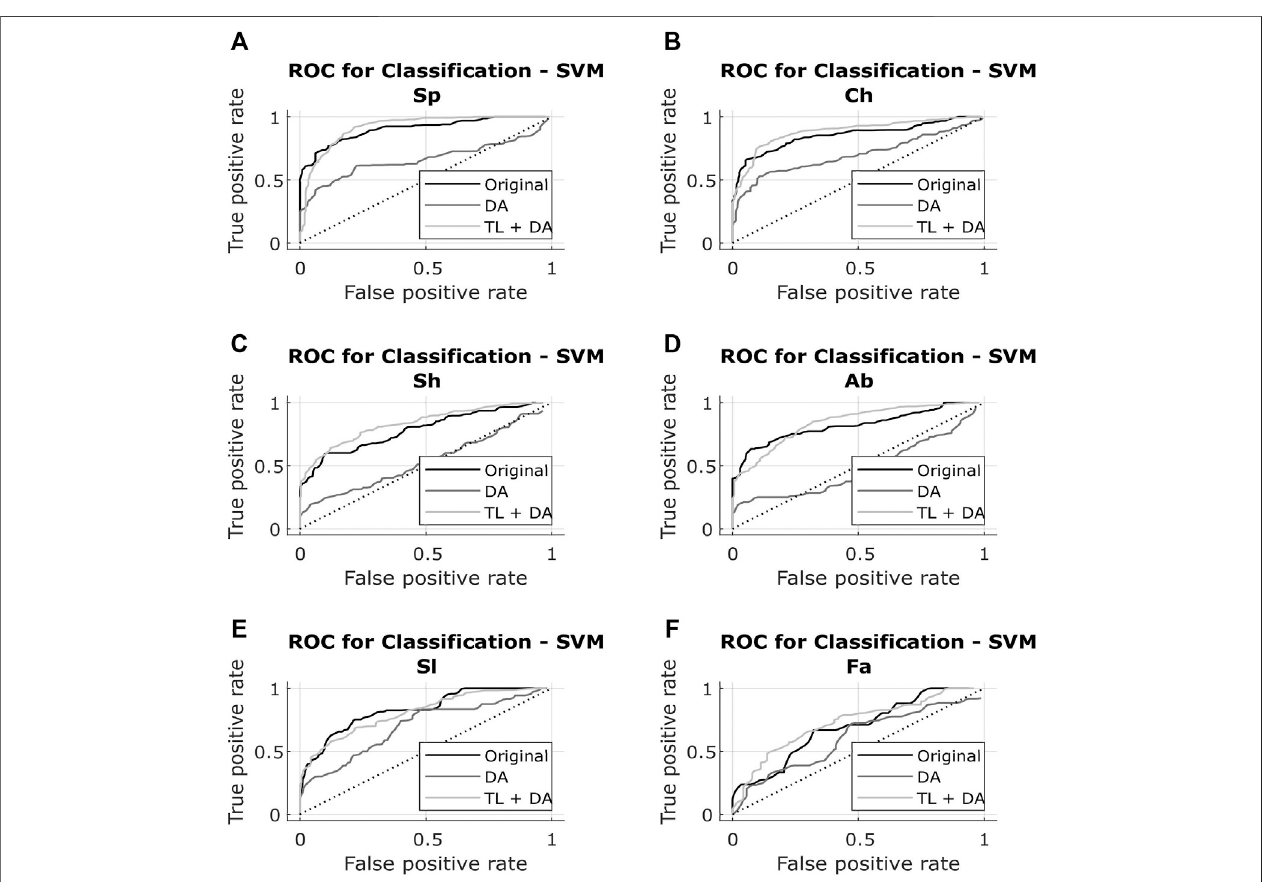
FIGURE 5 | ROC of the SVM models for each of the sub-groups of the BS dataset (A) Spontaneous breathing (Sp) (B) Chest breathing (Ch) (C) Shallow breathing (Sh)( D) Abdominalbreathing(Ab) (E) Slowbreathing(Sl)( F) Fastbreathing(Fa).ThecurvespresentthemedianROCforeachmodel,inblacktheoriginal,indarkgraythe SVM-DA and in light gray the SVM-TL + DA. The dotted line corresponds to the random guess. It is observed that in all the breathing types the DA model presents a worse behavior than the other models, and that the TL + DA model shows a similar behavior to the Original one.